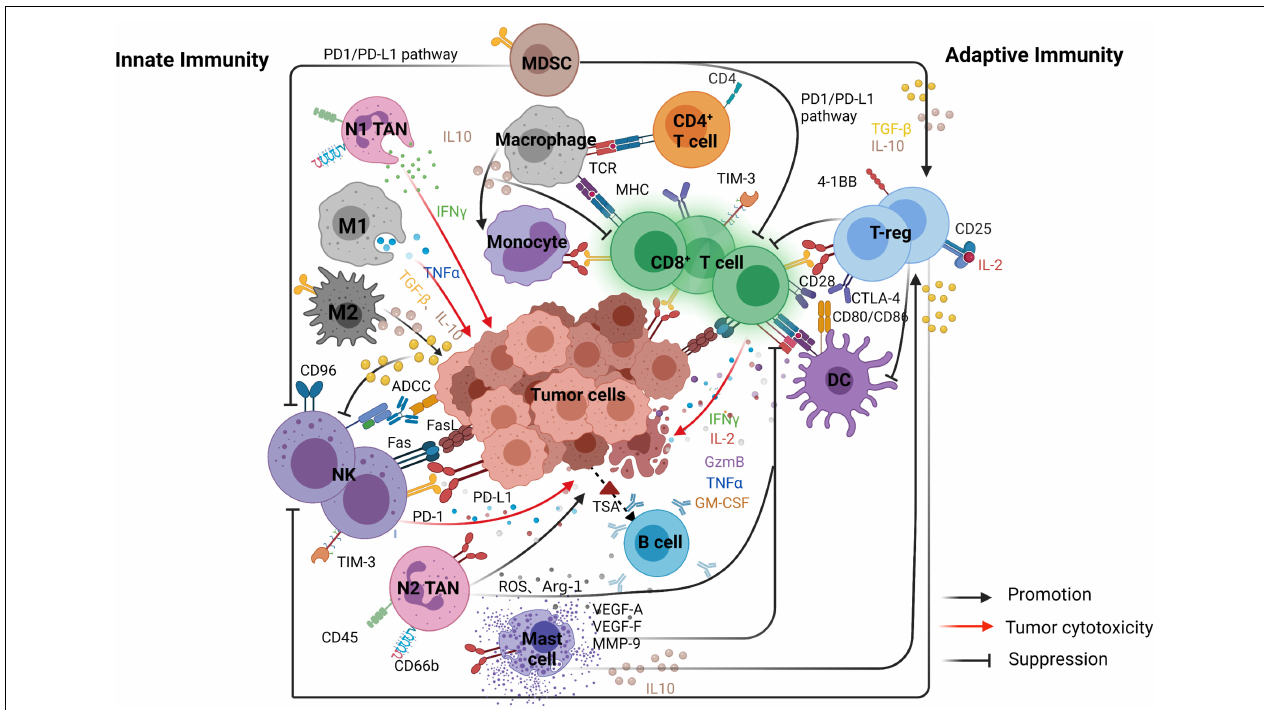
FIGURE 1 | The main interactions of immune cells and the relationships between tumor and immune cells in the TME. The figure is divided into two parts to show the complementary and interdependent relationship between innate and adaptive immunity. Left, represents innate immunity included natural killer (NK) cells, dendritic cells (DCs), tumor-associated macrophages (TAMs), and tumor-associated neutrophils (TANs). Right, represents adaptive immunity included CD8 + cytotoxic T cells (CTLs), CD4 + T helper 1 (Th1), and B